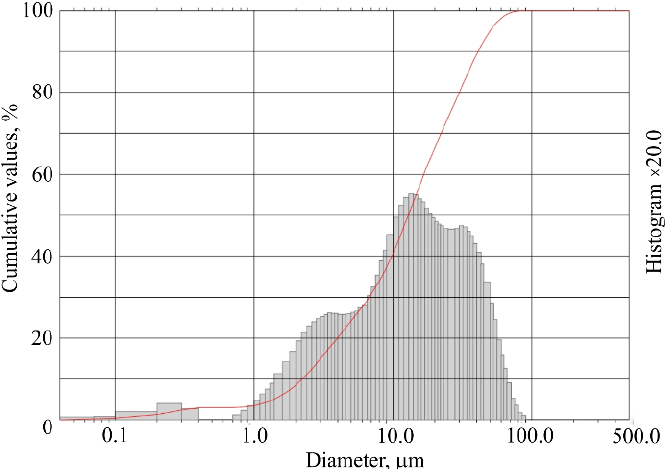
Figure 2. Distribution of milled quartz sand particles by size.